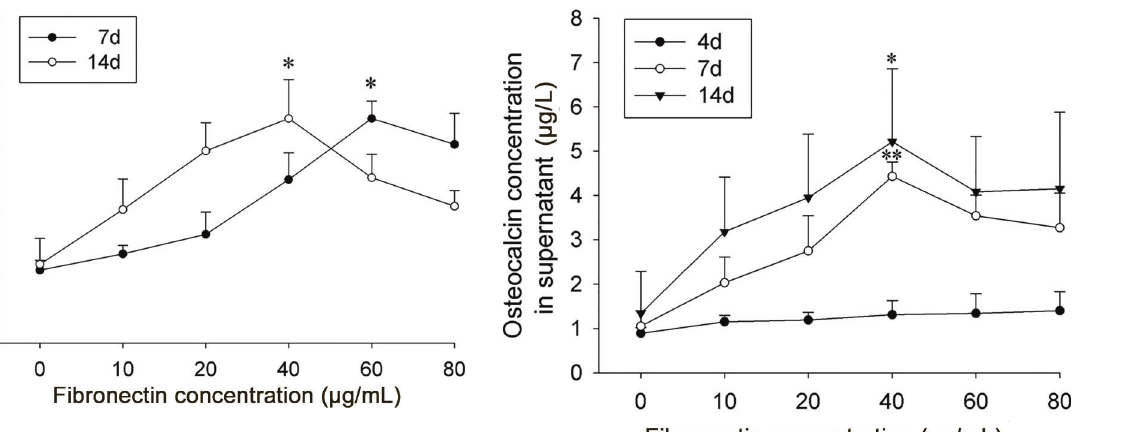
Figure 7. 3 H-TdR incorporation test indicating that fi bronectin regulated the DNA synthesis of fi broblasts. The 60 m g/mL fi bronectin concentration at 7 days and the 40 m g/mL fi bronectin at 14 days had signi fi cantly higher DNA synthesis compared to the other groups (*P o 0.05, ANOVA). Data are reported as means ± SD. cpm: counts per minute.